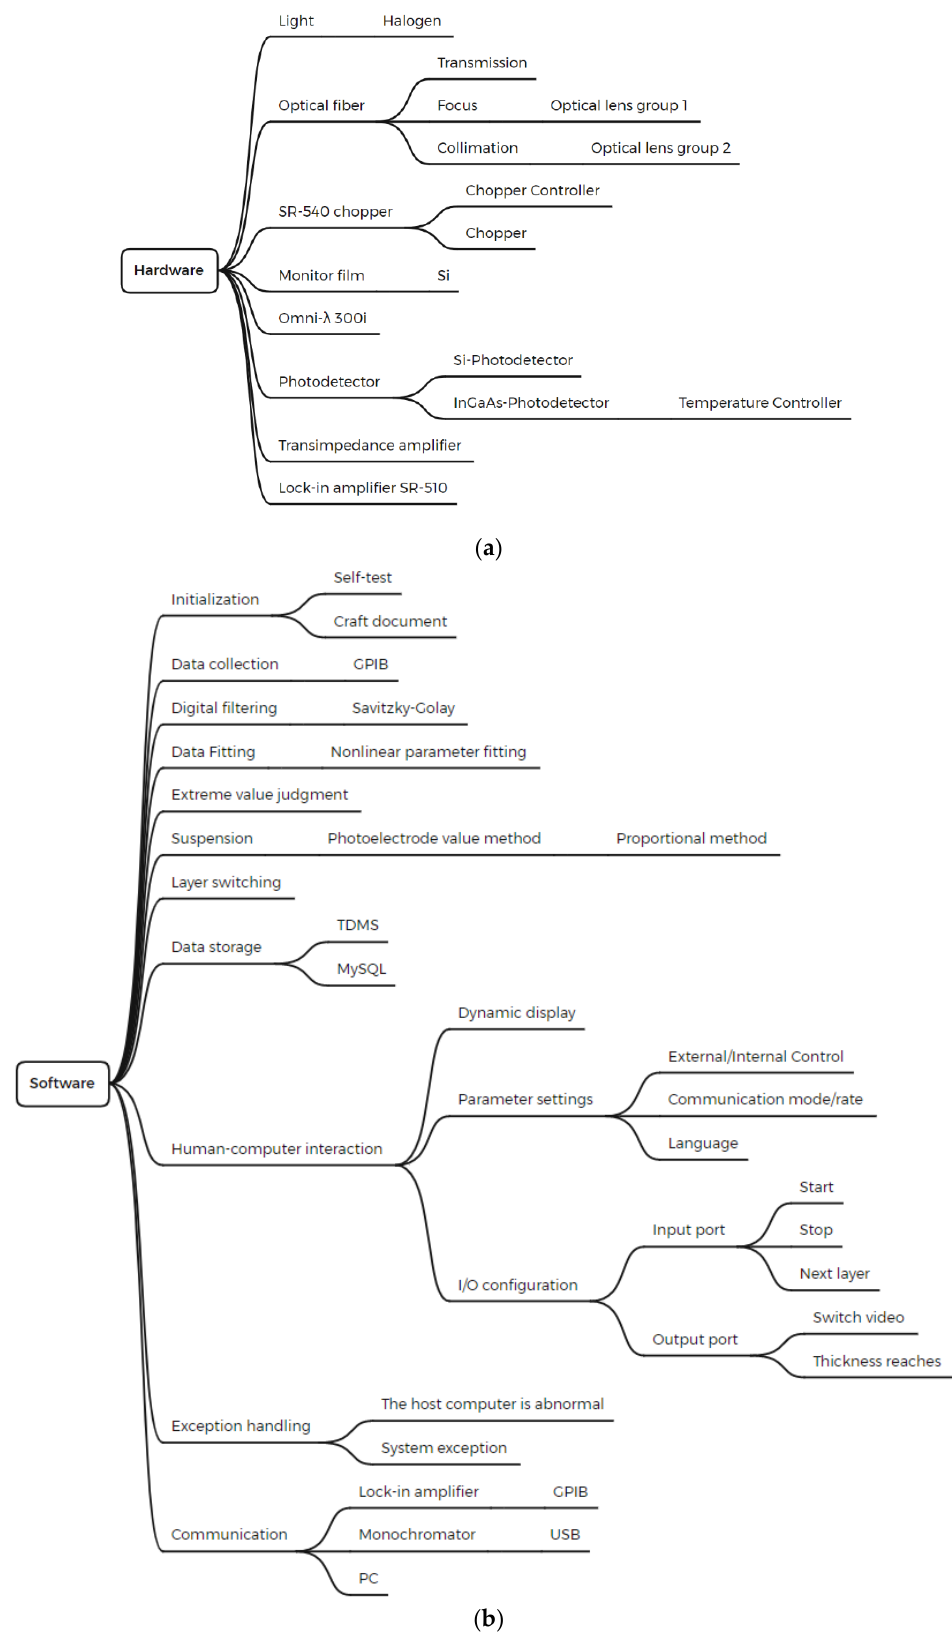
Figure 1. ( a ). Structure block diagram of infrared optical monitor control system hardware. ( b ). Struc- ture block diagram of infrared optical monitor control system